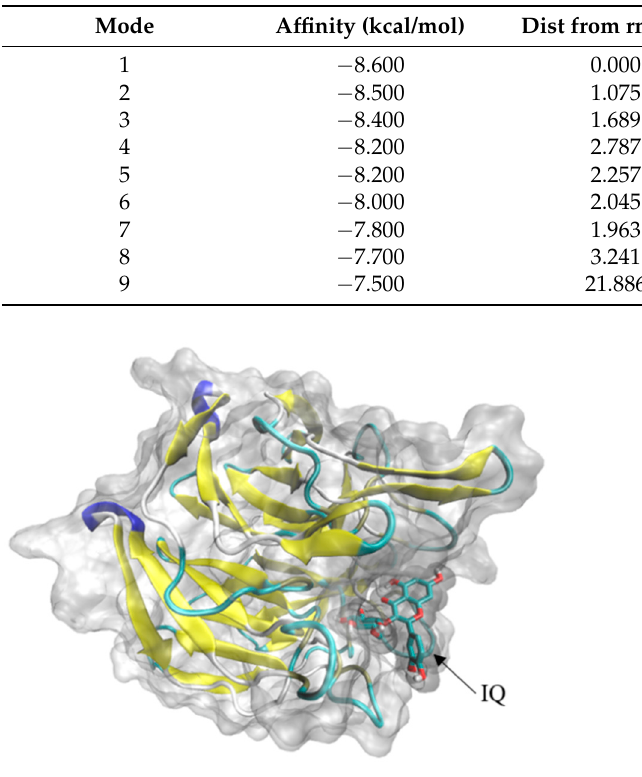
Figure 5. 3D molecular docking diagram of IQ with Keap1. Affinity = − 8.6 kcal/mol. Coordinate parameter: center x = 2.102, center y = 31.44, center z = 68.757, size x = 59.85, size y = 51.3, size z = 44.65; other parameters are the default Auto Dock Tools parameters. Table 1. Binding energy of IQ and Keap1.